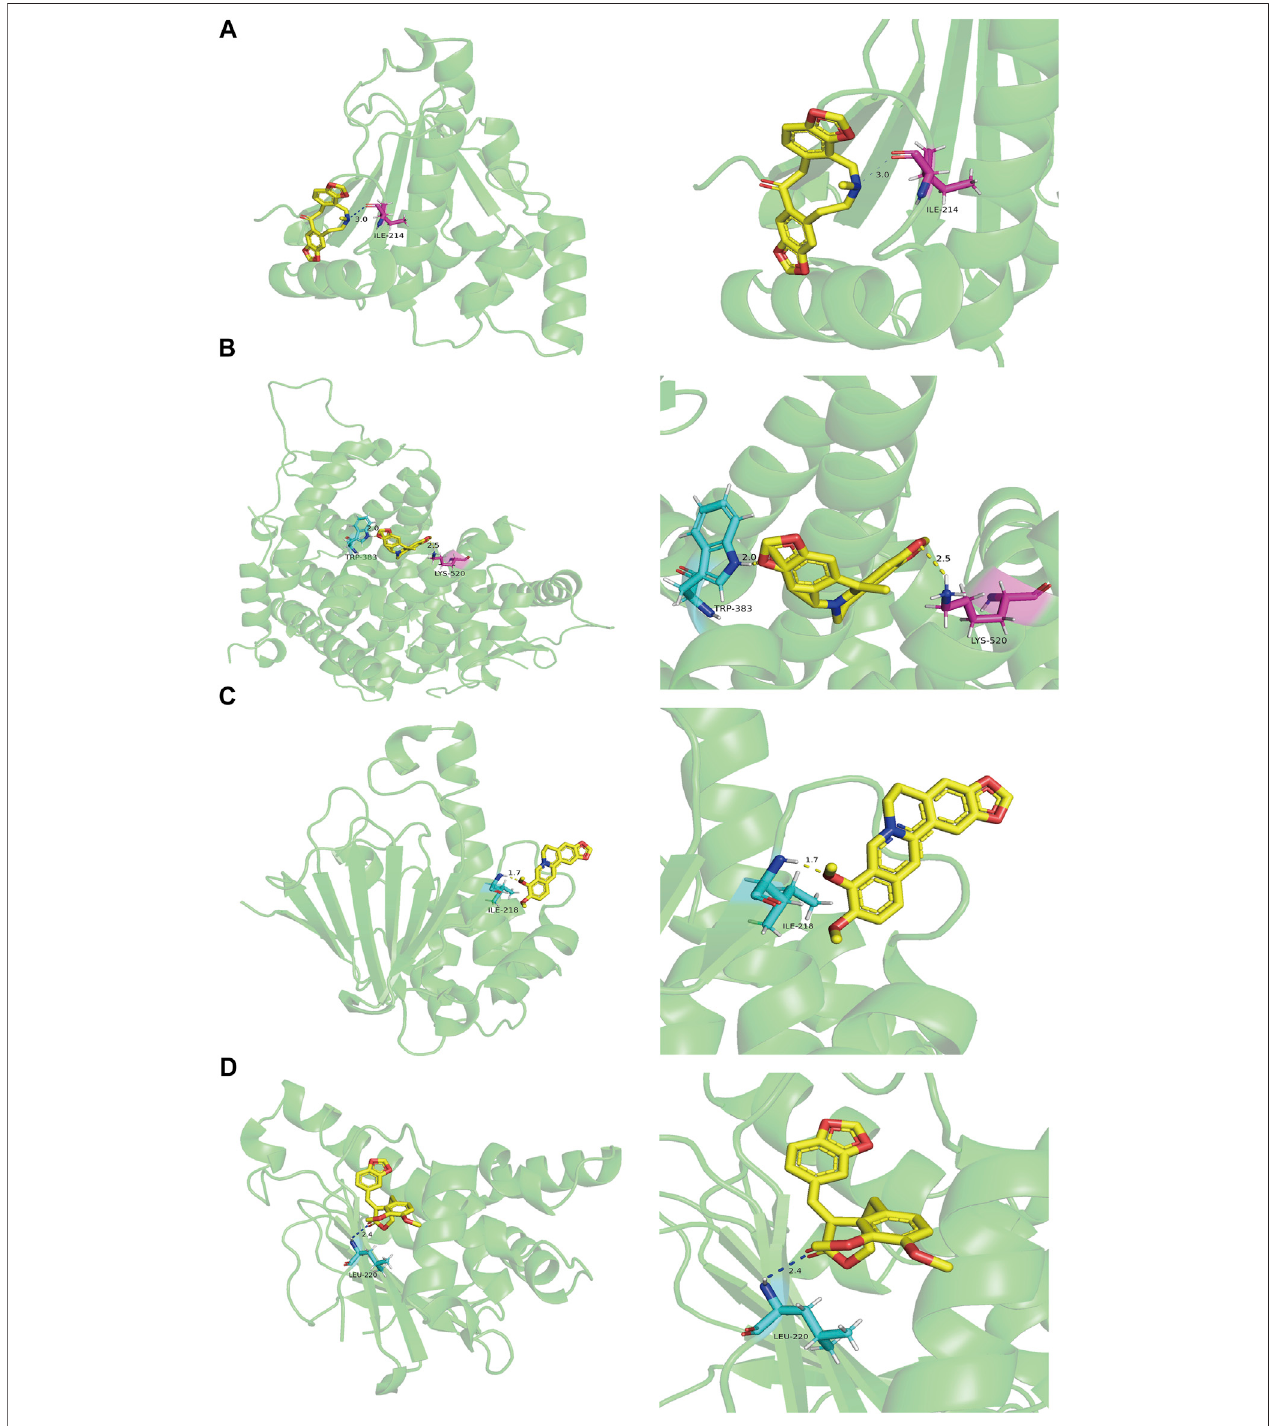
FIGURE6 | The molecular docking results ofkeytargetsand their correspondingingredients. (A) Fumarine and HSP90AA1 (B) Worenine and ESR1 (C) berberine and HSP90AA1 (D) suchilactone and HSP90AA1.